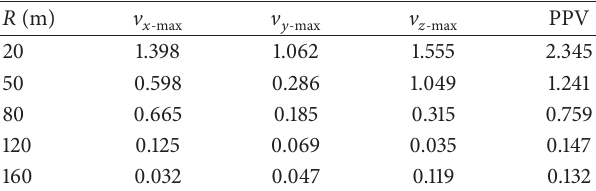
Figure 7: Setup diagram of vibration tester TC-4850. Table 1: Blasting vibration data